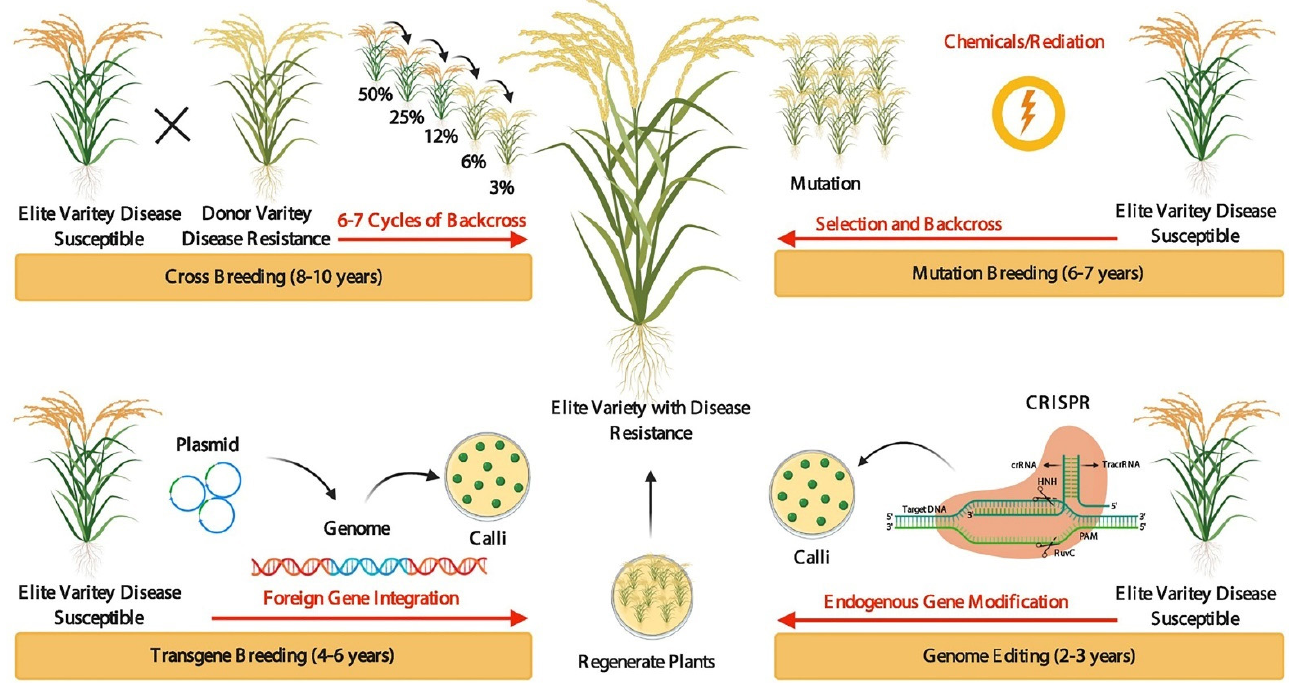
Figure 1. Evolution of crop breeding techniques. Crossbreeding takes a great deal of time (8–10 years) to improve desirable characters/traits (in a particular species for disease tolerance or resistance) through crossing an elite variety line with a donor variety line and selecting the new outstanding offspring with desirable characters/traits. To introduce new progeny with desirable traits from the donor variety line to the elite variety line, the selected offspring must be backcrossed to the elite variety line for several years to remove undesirable related traits. In mutation breeding, mutations are used to improve traits in the time (6–7 years) of the genome through chemical treatment or physical irradiation to create novel genetic variations. Transgenic breeding is easy and well-known, improving crop traits within (4–6 years) by the exogenous transformation of genes into economically important elite varieties. Genome editing: improving a targeted trait in a very fast and short time (2–3 years) and exactly revising the target gene or regulatory sequence or changing the DNA and/or RNA bases in elite